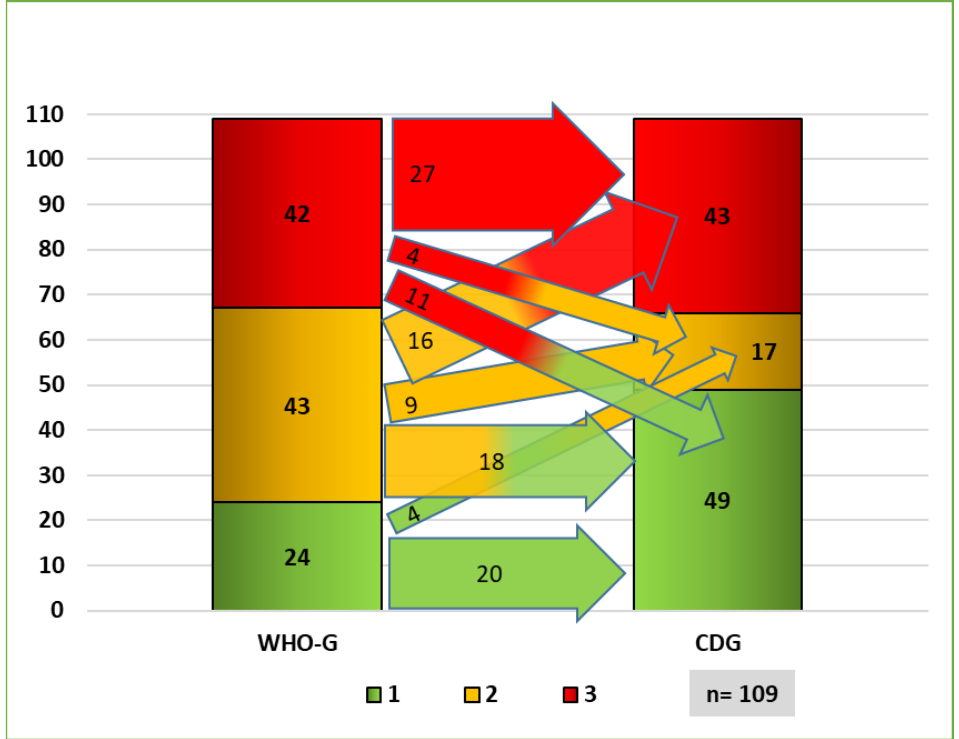
Figure 7. Flowchart of distribution of both grading systems.